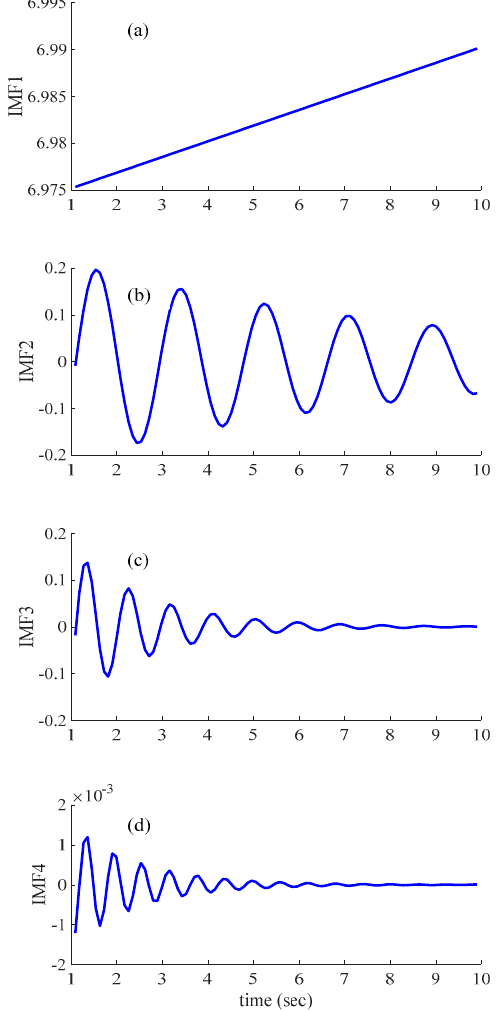
Figure 10. Extracted IMFs of PG1 in Test Case 2. ( a – d ) IMF1 to IMF4, respectively.